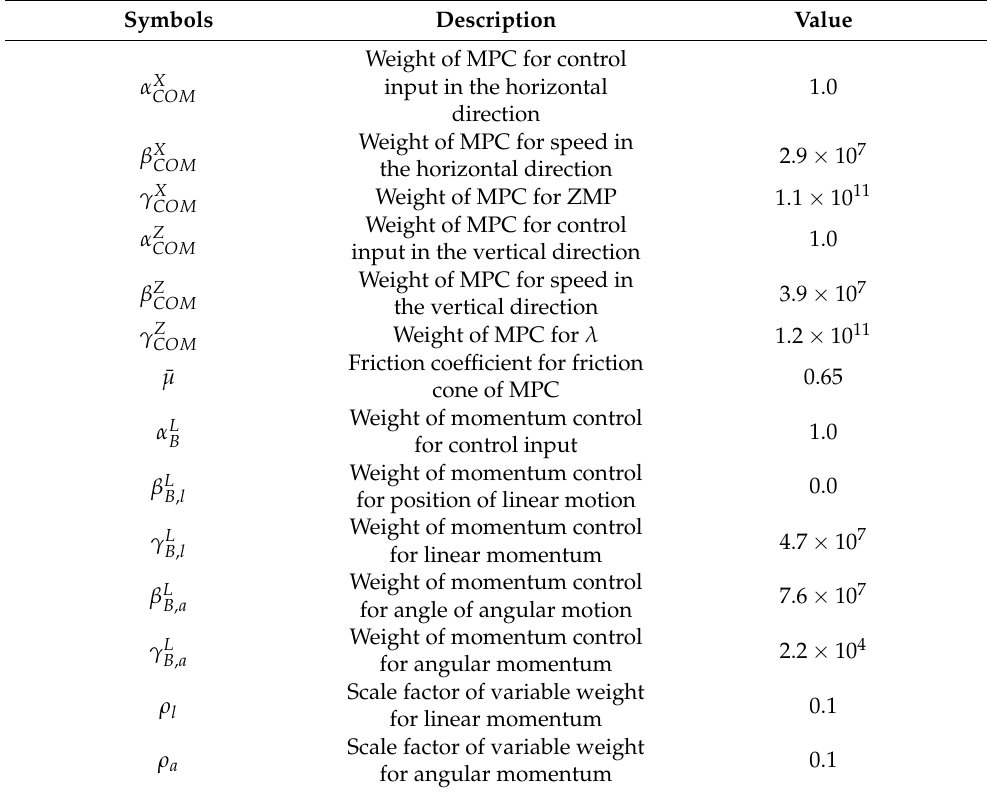
Table 4. Control